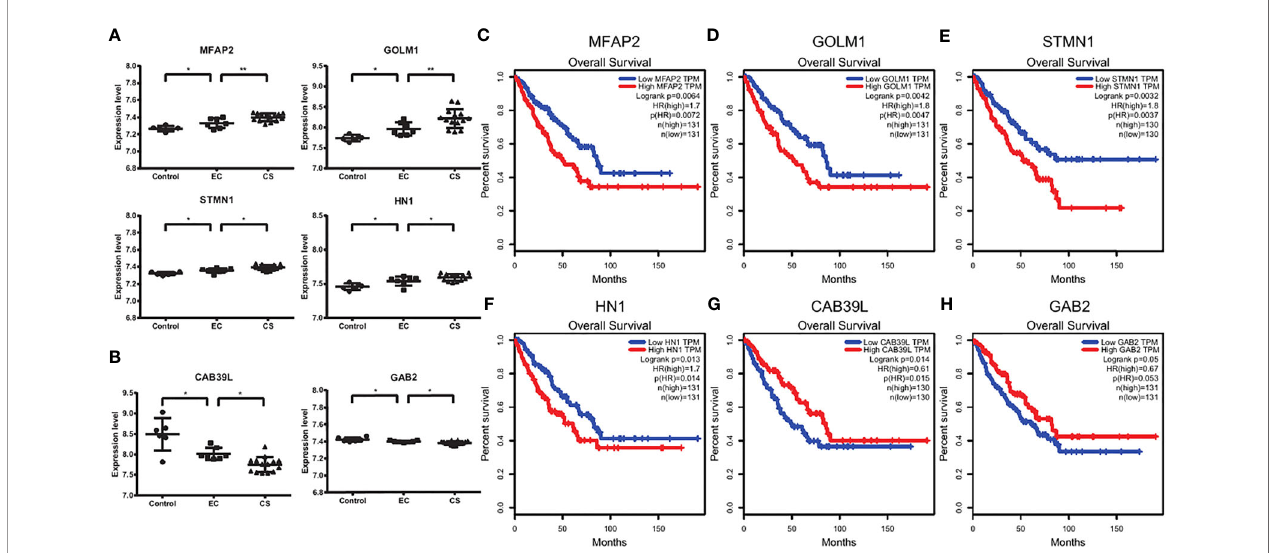
FIGURE 4 | Survival analysis suggesting the prognostic factors. (A, B) The expression levels of MFA2, GOLM1, STMN1, HN1, CAB39L, and GAB2 in control, EC, and CS groups. Each dot represents a sample. *p < 0.05, **p < 0.01. (C – H) The overall survival plots using GEPIA. Red and blue represent high and low expression level groups of MFAP2 (C) , GOLM1 (D) , STMN1 (E) , and HN1 (F) , CAB39L (G) and GAB2 (H)